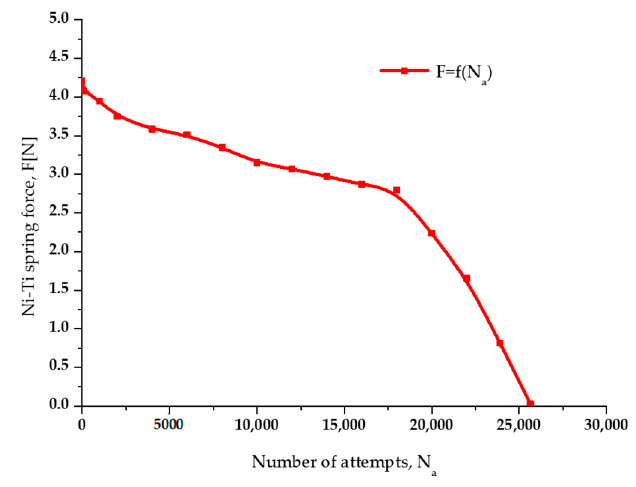
Figure 7. The force variation generated by the Ni-Ti during the test period (5 days of continuous operation) at the applied electric current, I 2 .